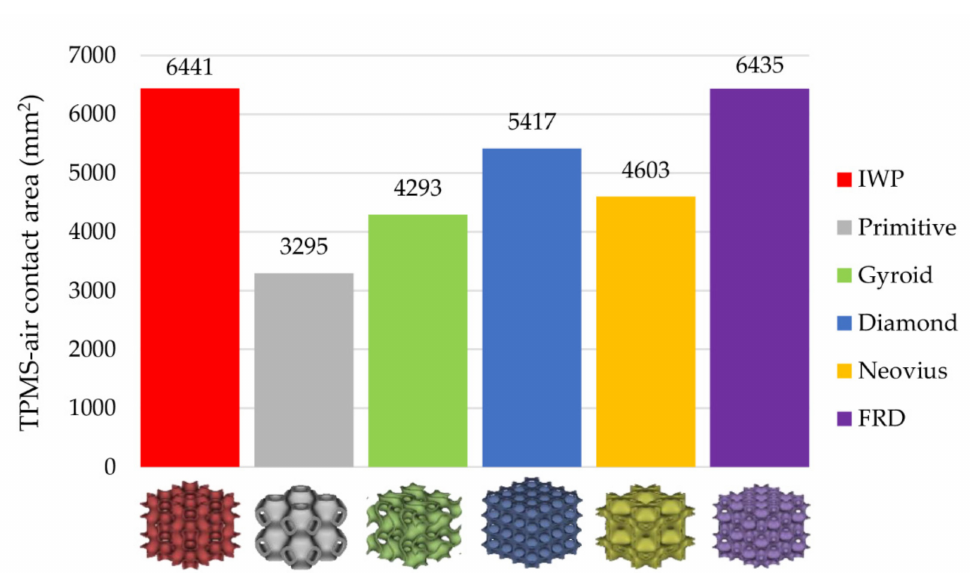
Figure 13. The value of the TPMS-air contact area of each